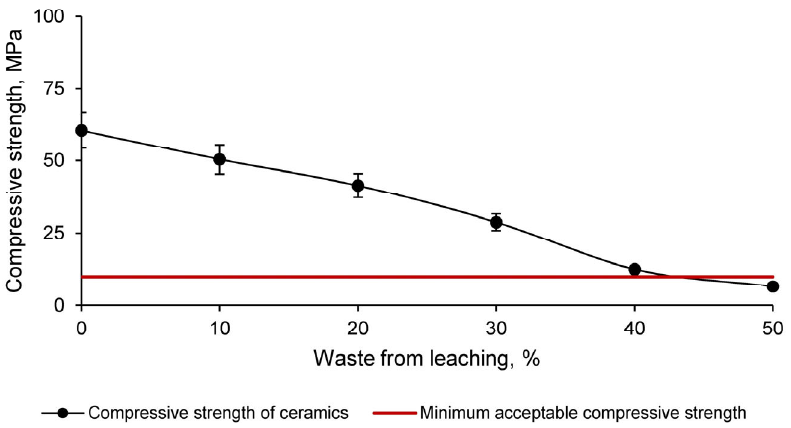
Figure 10. Compressive strength of different families of clay ‐ conformed ceramics and leaching res ‐